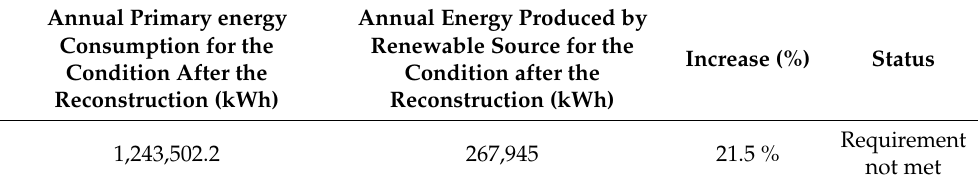
Table 29. Evaluation of the experiment in terms of RES